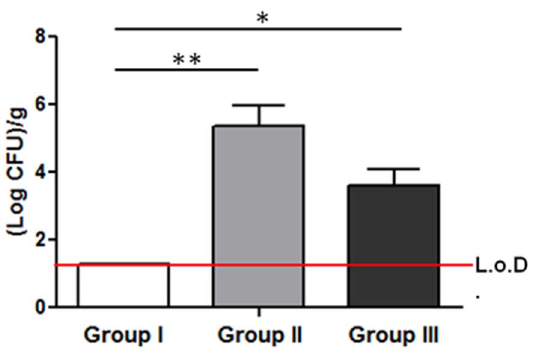
Fig. 5. Bacterial load in bones of all the experimental groups. No colonies were detected in group I, the sham control (L.o.D. = limit of detection). With an infecting dose of 1 6 10 3 CFU/mouse, a mean of 5.3 6 1.2 (Log CFU)/g of bone was found in the explants of group II, with a statistical difference in respect to group I. A mean of 3.6 6 0.9 (Log CFU)/g of bone was found in the explants of group III, with a statistical difference in respect to group I (one-way ANOVA, *P , 0.05; **P , 0.01; n=4).